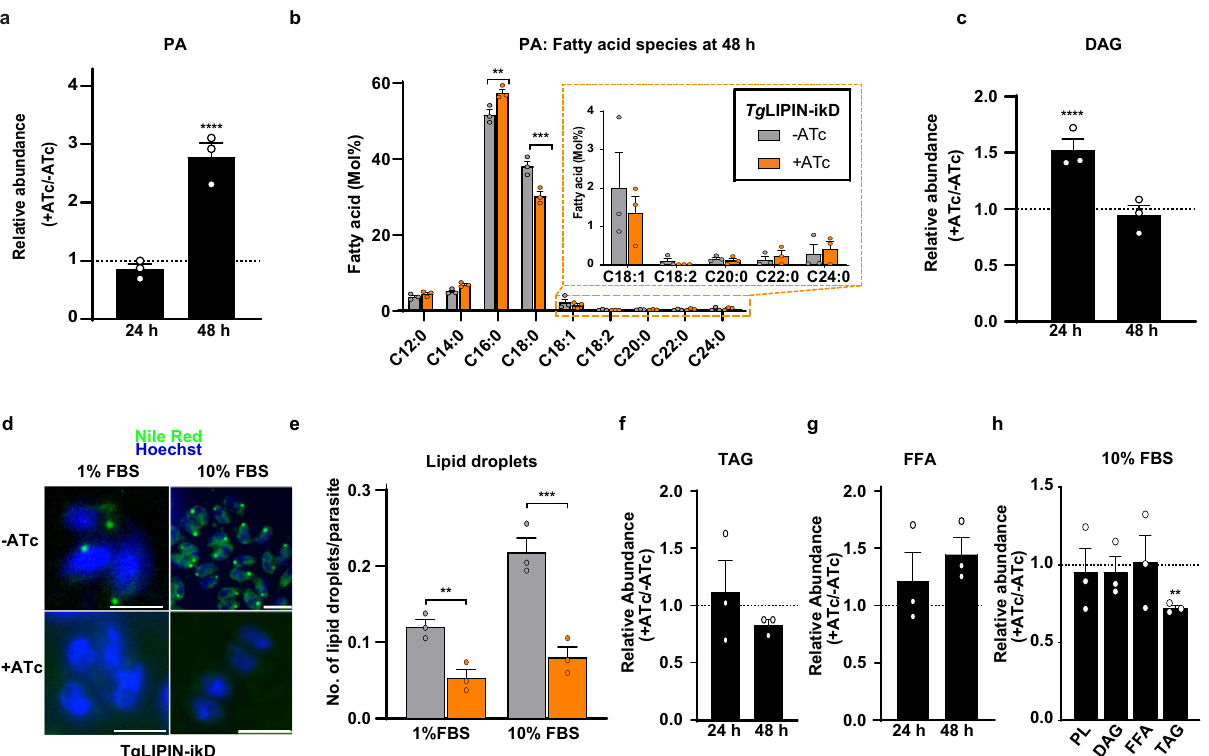
Fig. 4 Tg LIPIN regulates critical levels of PA and other major phospholipids while generating DAG that is directed toward neutral lipid storage. a Relative abundance of PA in Tg LIPIN-ikD (nmol/parasites number, + ATc/ − ATc; %; n = 3, unpaired t test P values where **** P < 0.00001 relative PA abundance ratio nmol/parasites number + ATc/ − ATc at 48 h vs + ATc/ − ATc = 1). b Fatty acid composition of PA in Tg LIPIN-ikD ( + / − ATc) in Mol%; n = 3, unpaired t test P values where ** P < 0.0021 PA C16:0 − ATc vs + ATc, *** P < 0.0002 PA C18:0 − ATc vs + ATc. c Relative abundance of DAG ( + ATc/ − ATc) is reduced by Tg LIPIN depletion after 48 h + ATc ( n = 3, unpaired t test P values where **** P < 0.00001 relative DAG abundance ratio nmol/parasites number + ATc/ − ATc at 24 h vs + ATc/ − ATc = 1). d Nile red staining showed the number of lipid droplet within the parasites after 24 h of + / − ATc (scale bar = 5.0 μ m) with ( e ) a representative bar graph ( n = 3, unpaired t test P values where ** P < 0.0093 number of lipid dro p lets per parasite + ATc/ − ATc at 1% FBS, *** P < 0.0003 at 10% FBS). f Relative abundance of TAGs in Tg LIPIN-ikD ( + ATc/ − ATc) showing that TAG levels were relatively reduced in the Tg LIPIN-ikD (48 h + ATc). g Relative abundance of free fatty acids (FFA, + ATc/ − ATc in the Tg LIPIN-ikD). h Relative abundance of PLs, DAG, FFA and TAG in the Tg LIPIN-ikD + ATc to − ATc at 10% FBS ( n = 3, unpaired t test P values where ** P < 0.004 relative TAG abundance ratio nmol/ parasites number + ATc/ − ATc at 10% FBS vs + ATc/ − ATc = 1). Data are presented as mean values + / −